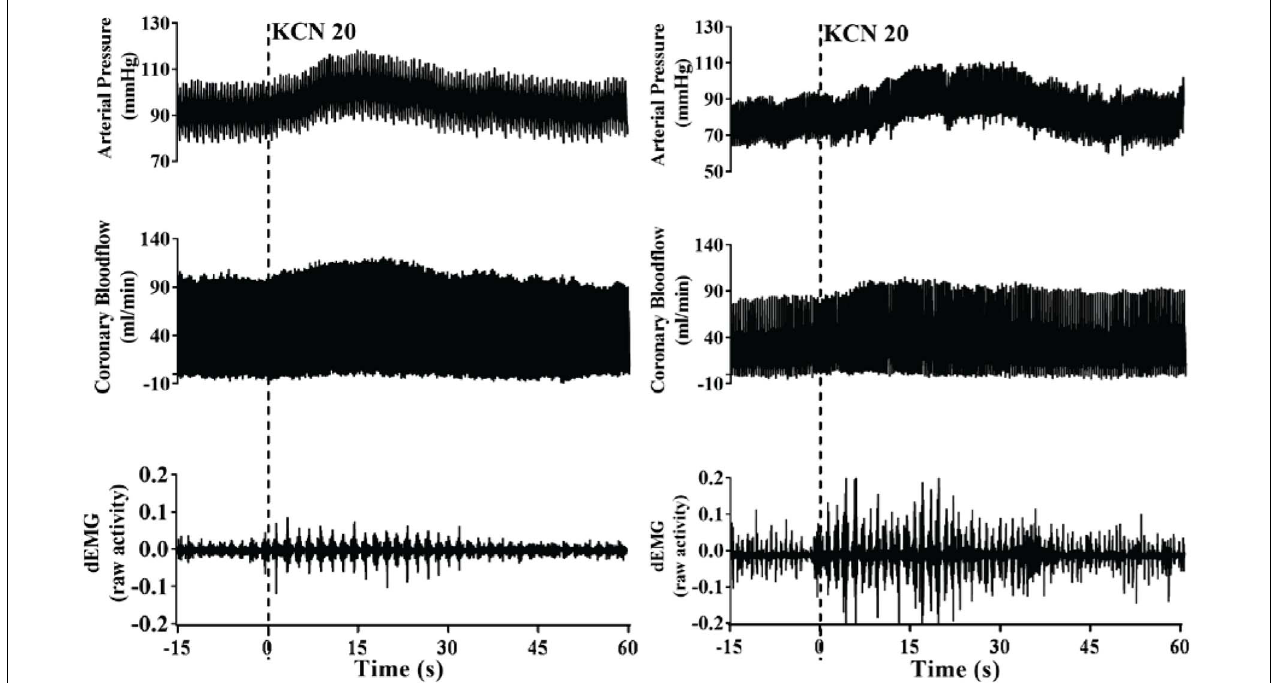
FIGURE 1 | Representative raw traces from one control animal (left) and one heart failure animal (right) demonstrating changes in arterial blood pressure, coronary blood flow, and dEMG in response to intra-carotid potassium cyanide at a dose of 20 µ g/kg.